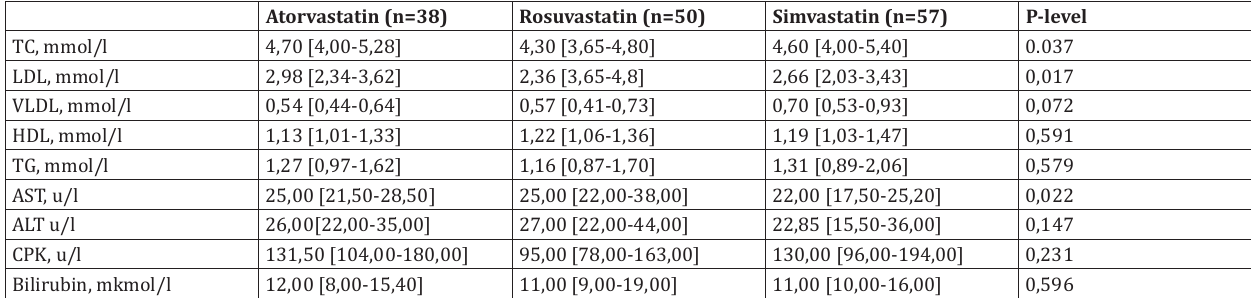
Comparative characteristics of groups depending on the choice of statin on the basic laboratory parameters.